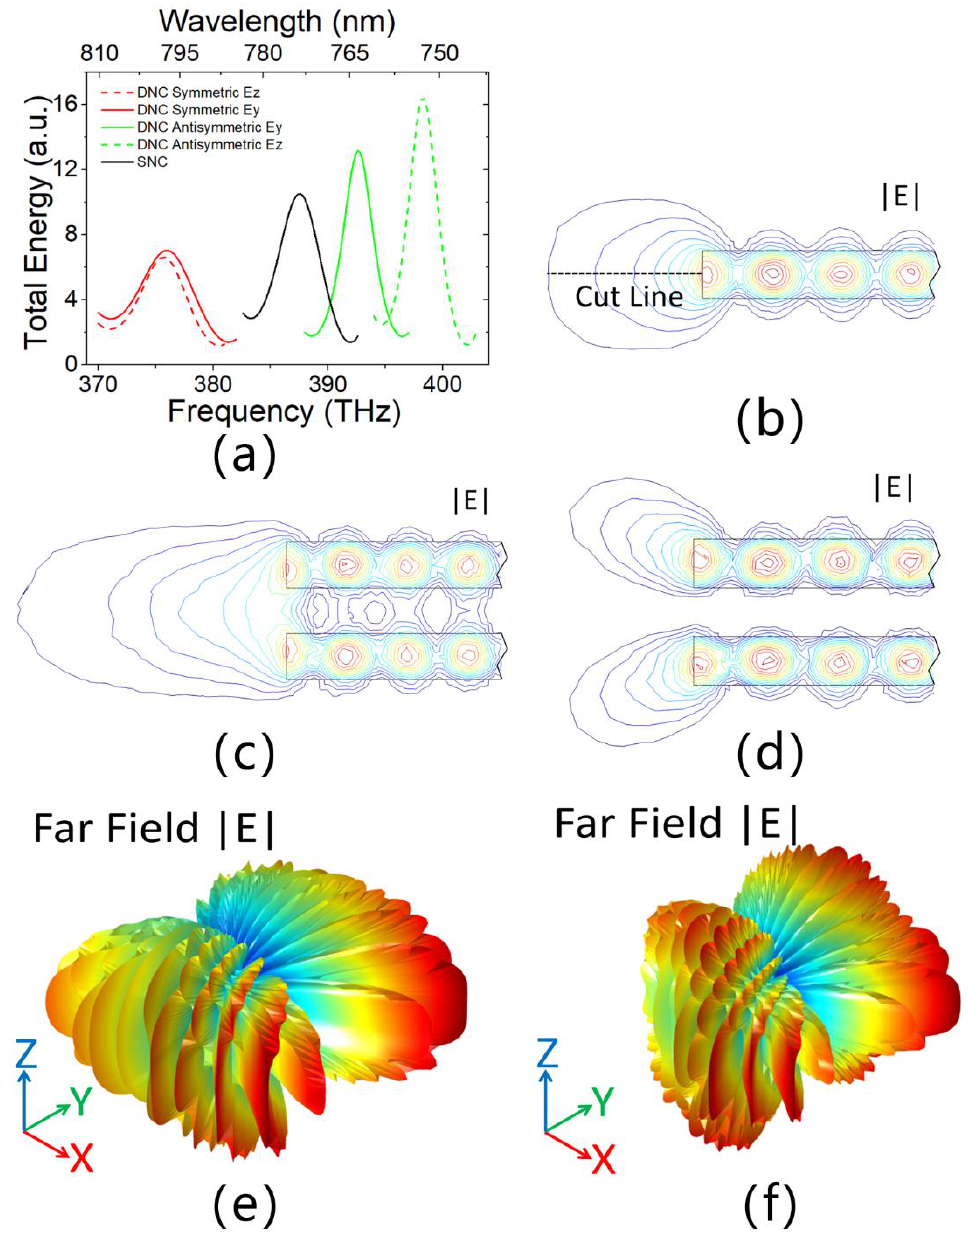
Figure 2. ( a ) Total energy spectra for the mode of SNC and corresponding four supermodes of DNC at S 1 = 0.1 um. Contour plot of the electric field norm for a longitudinal mode of SNC ( b ), symmetric E z modes of ( c ), and antisymmetric E z modes ( d ) for DNC at S 1 = 0.2 um. The lobe pattern of the electric field norm at the far field for antisymmetric E y mode ( e ) and antisymmetric E z mode ( f ) for DNC. Different Q factors for symmetric and antisymmetric modes and two polarizations